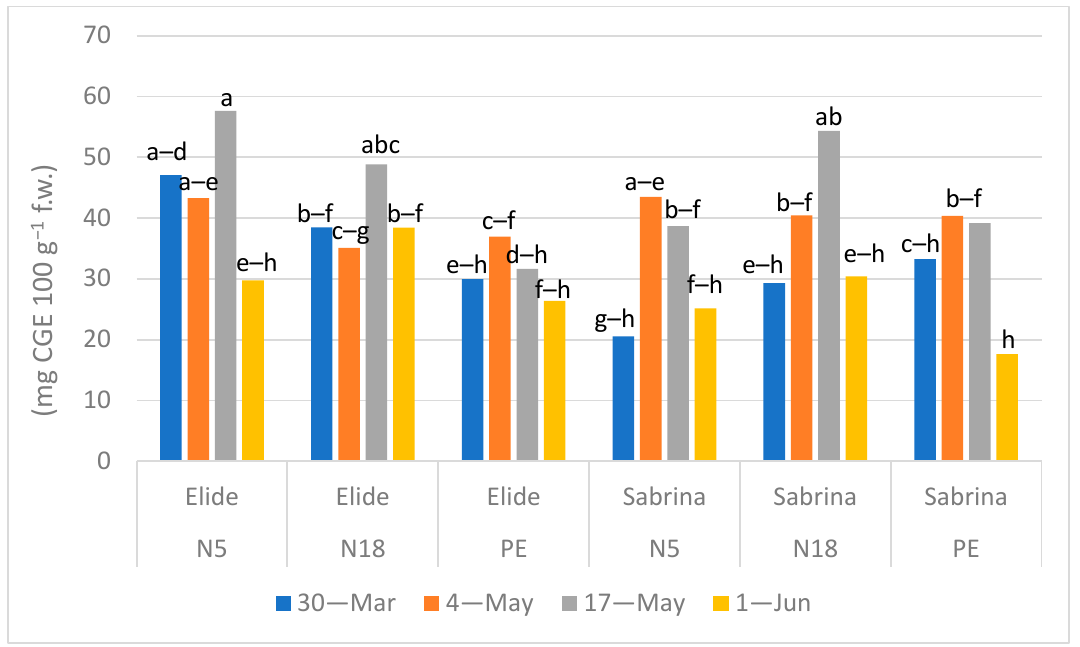
Figure 4. Effect of Mulch × Cultivar × Time of sampling interaction ( p < 0.0001) in anthocyanins content (mg CGE 100 g − 1 f.w.). Means followed by the same letter do not differ significantly at p = 0.05 (Tukey HSD test).